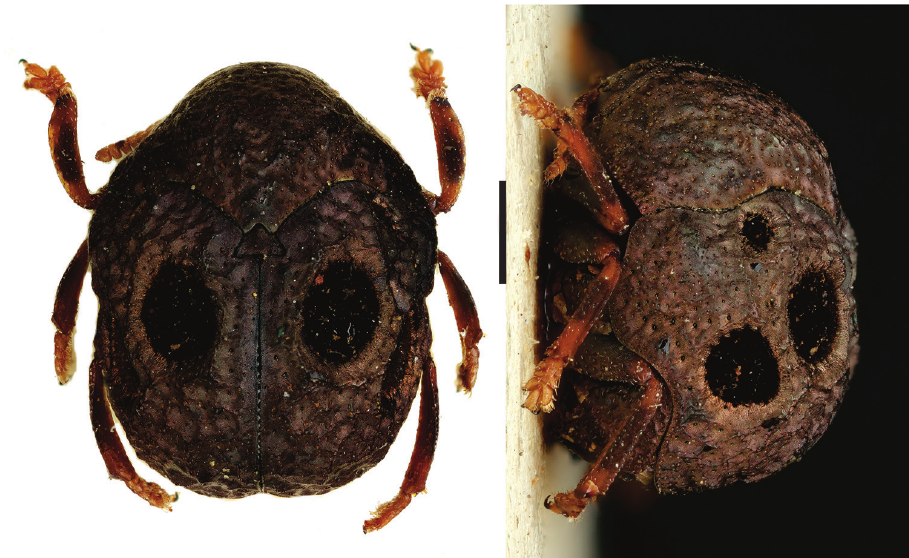
Figure 32. Melittochlamys specula (Klug) (2) , left: habitus (dorsal view), right: habitus (lateral Melittochlamys Monrós, 1948a Fig. 32 Melittochlamys Monrós, 1948a: 192; Fiebrig 1910: 253; Monrós 1949b: 617; Monrós 1951c: 666; Seeno and Wilcox 1982: 43; Chamorro-Lacayo and Konstantinov 2009: 80. Type species. Chlamys speculum Klug 1824, by original designation.